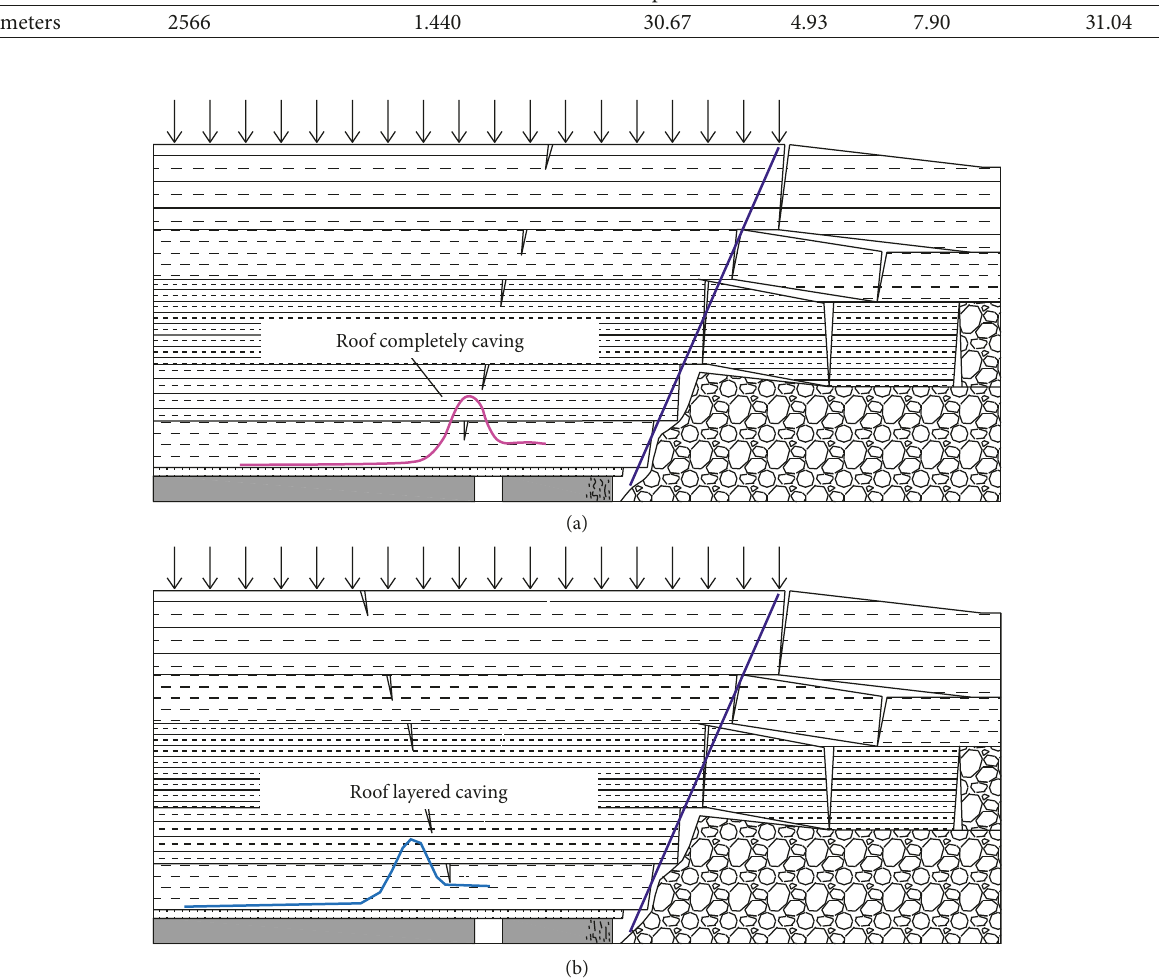
Figure 4: Lateral support pressure distribution of coal seam under different roof caving forms: (a) roof completely caving; (b) roof layered